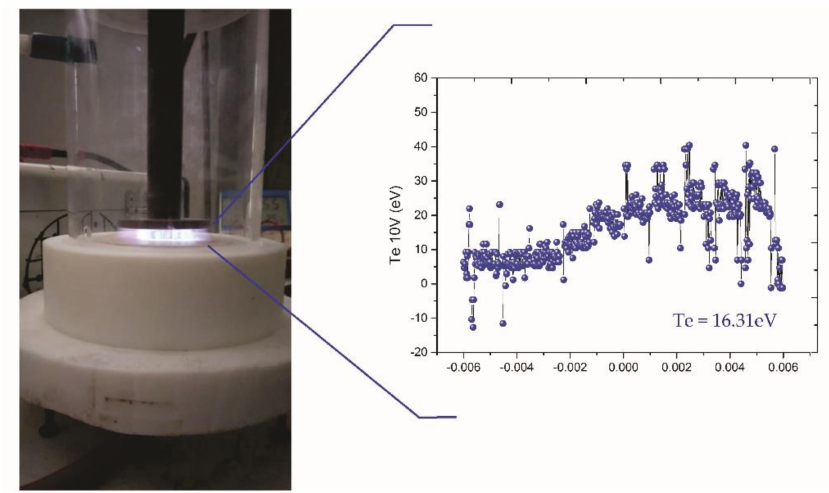
Figure 2. High-density polyethylene (HDPE) during the treatment and the behavior of the electronic temperature of the